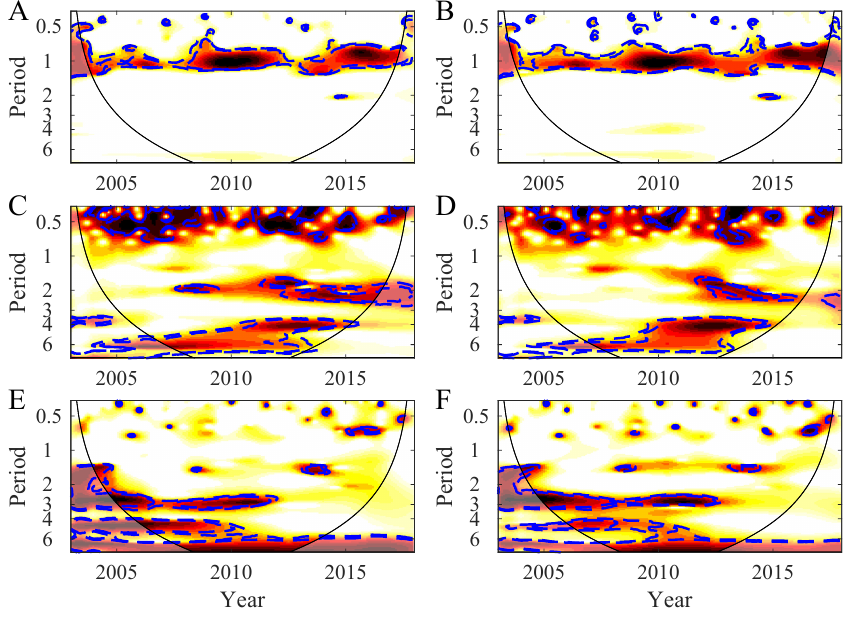
Figure 4. Partial Wavelet Coherence ( A ) between Chl–a–North and SST–North controlled by SAM and SOI. ( B ) between Chl–a–South and SST–South controlled by SAM and SOI. ( C ) between Chl–a–North and SAM controlled by SST–North and SOI. ( D ) between Chl–a–South and SAM controlled by SST–south and SOI. ( E ) between Chl–a–North and SOI controlled by SST–North and SAM. ( F ) between Chl–a–South and SOI controlled by SST–South and SAM. Blue dashed lines indicate the 95% and 90% significant areas obtained by adapted bootstrapping [55] and the cone of influence (solid black lines) indicates the regions where the wavelet computations are not influenced by edge effects. The colour code for synchrony values is graded from yellow (low synchrony) to red (high synchrony). Periods of variability (in years) of the y -axis are on log 2